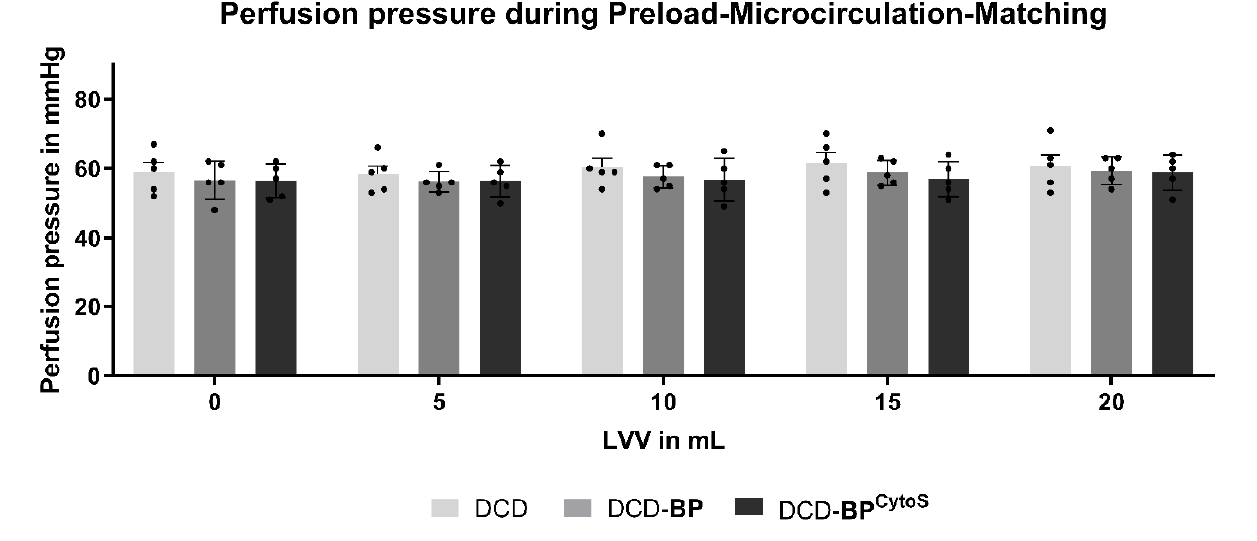
Figure 3. Perfusion pressure. Light grey: DCD. Grey: DCD-BP. Dark grey: DCD-BP CytoS . LV: left ventricular. MP: machine perfusion. BP: blood perfusion. DCD: donation after circulatory death. BP CytoS : blood perfusion with an integrated cytokine adsorption device.